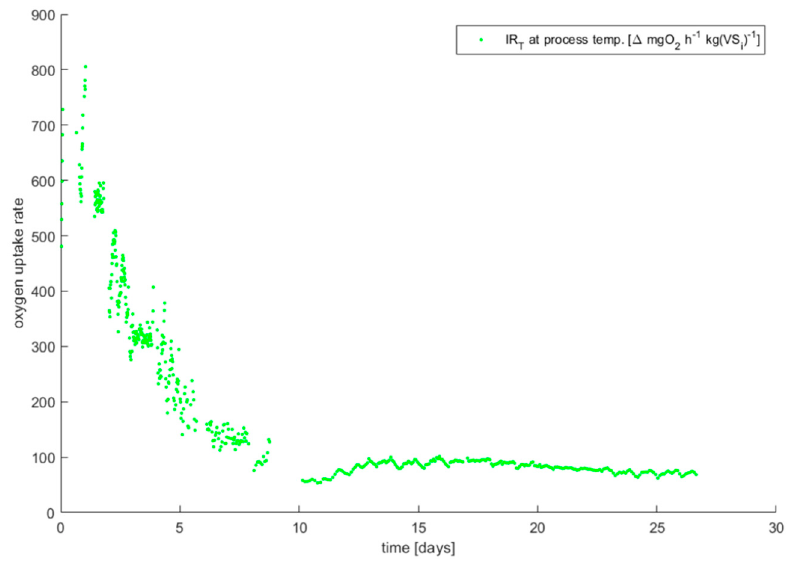
The previous black dots graph is isolated in Figure A4 (now in green dots). The DRI data curves of all the mixes tested are superposed in Figure 8.